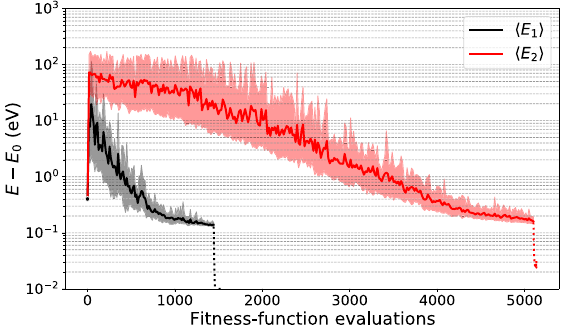
Fig. 3 Exploring the minima of an objective function. A reparametrization of the two-dimensional Ackley function, ffiffiffiffiffiffiffiffiffiffiffiffiffiffiffiffiffiffiffiffiffi (cid:6) 1 x 2 x 2 f ð x 1 ; x 2 Þ ¼ (cid:3) a exp (cid:3) b 1 þ 2 ð 2 þ e þ a , with a = 3, b = 1, c = π /3, chosen in such a way that the basins of the local minima and of the global minimum have a comparable width. In the inset, the function is evaluated on the x 2 = 0 plane. The red dot represents the location of m (0) and the red error bar represents the magnitude of σ (0) . The gray area represents a region of the search space where a gradient-based optimization approach would lead to the global